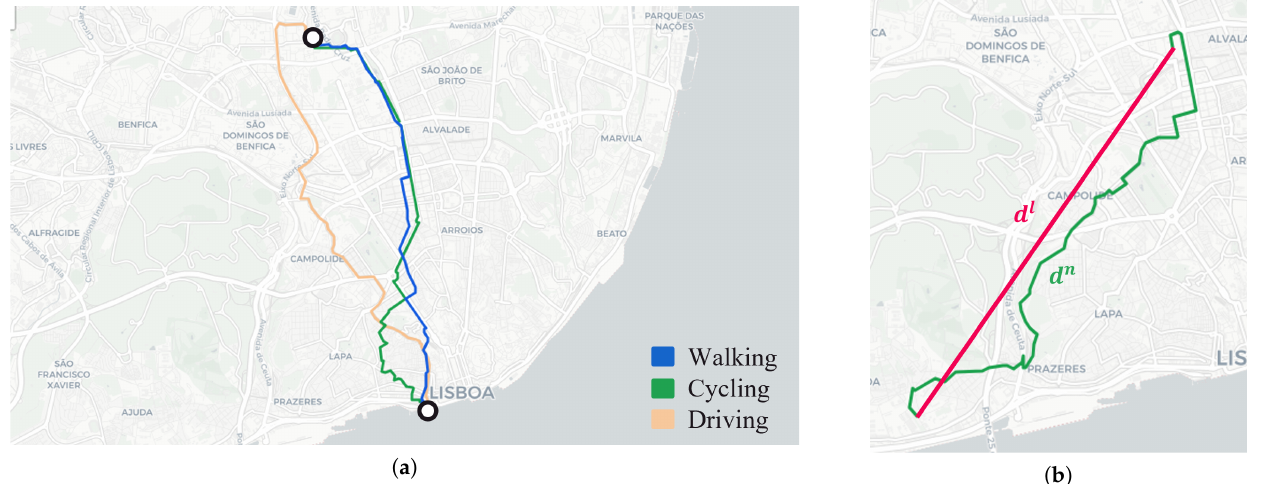
Figure 1. Driving (orange), cycling (green), and walking (blue) routes for an Origin-Destination pair ( a ), and circuity as the ratio of network distances and straight-line distance of one trip ( b